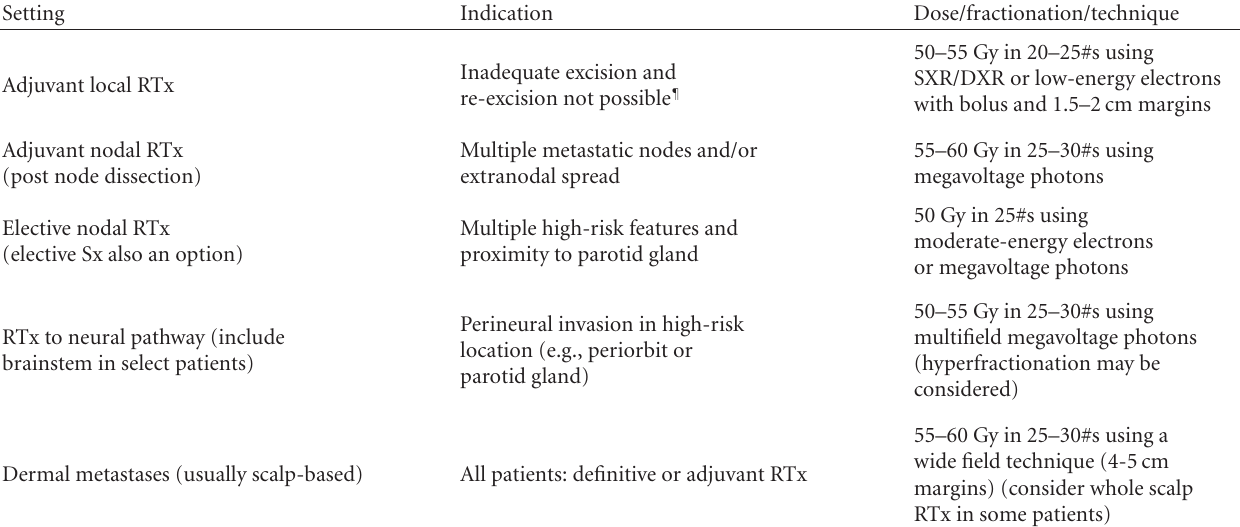
Table 2: Indications for radiotherapy in high-risk cutaneous squamous cell carcinoma. DXR: deep energy photons (orthovoltage); Gy: Gray; RTx: radiotherapy; SXR: superficial energy electrons; Sx: surgery; #: daily fraction of radiotherapy; ¶ : surgery would compromise function and/or